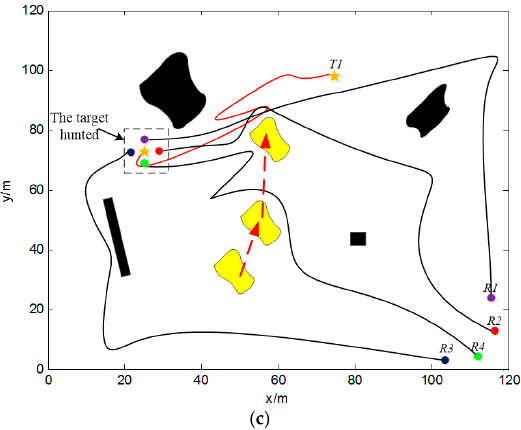
Figure 4. Simulation of hunting process with dynamic obstacle. ( a ) The initial state; ( b ) AUVs’ search trajectory for the target; ( c ) Final trajectories of the AUVs.